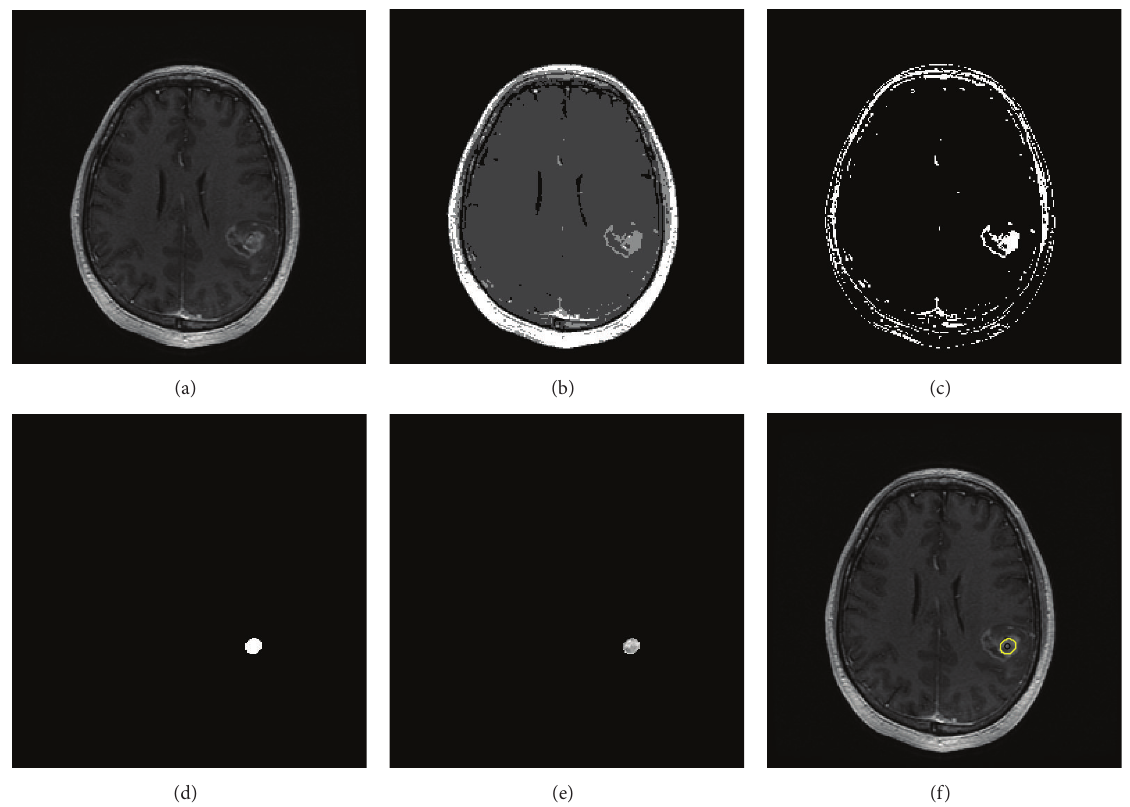
Figure 4: GBM detection by segmentation and morphology operations: (a) T1-MR image, (b) image segmented by four levels, (c) range of GBM gray level conserve, (d) filtering of (c), (e) raw GBM data detected, and (f) GBM located on the brain